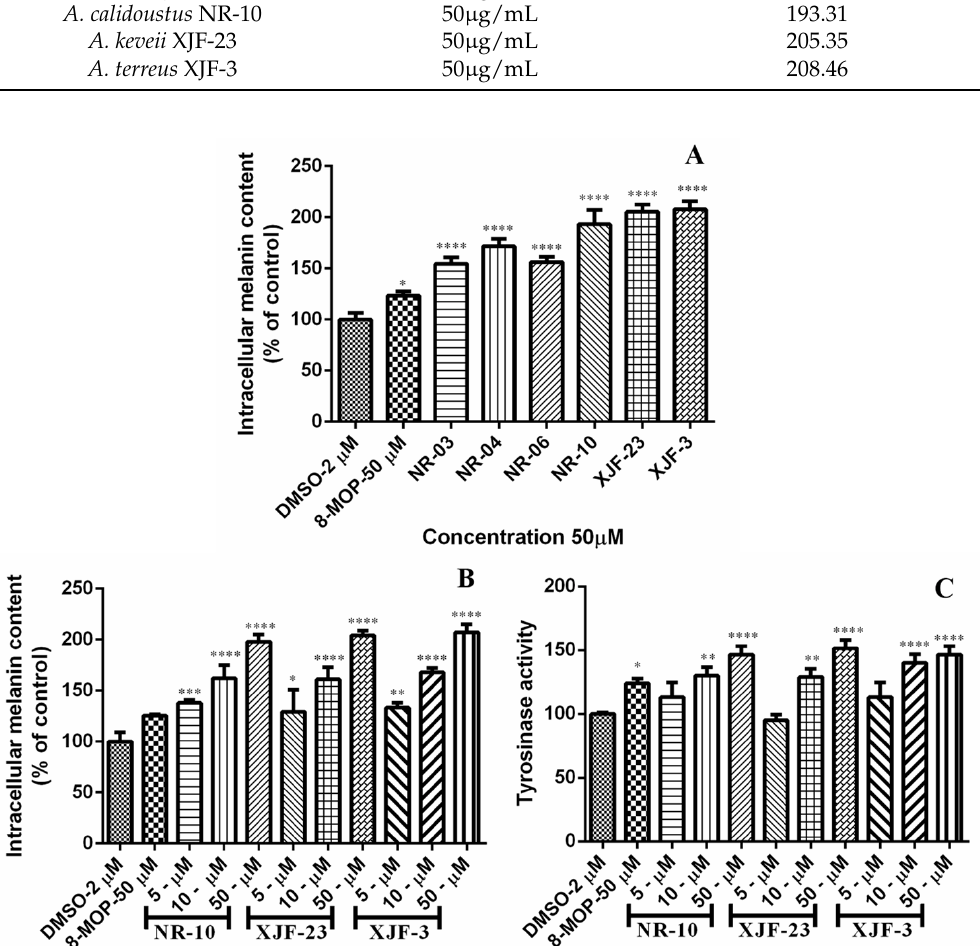
Figure 3. ( A ) Stimulation of melanin content of B16 cells by secondary metabolites of crude